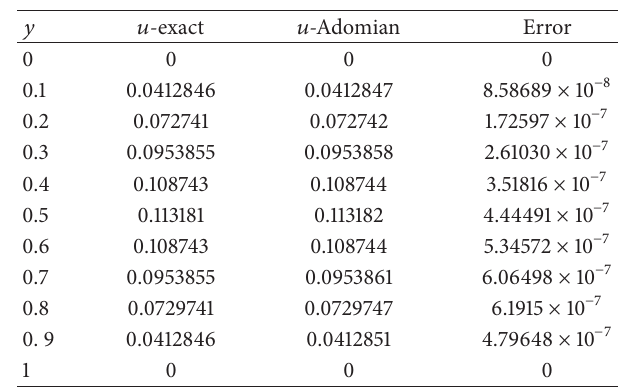
Table 1: Uniqueness results 𝑚 = 3 , 𝛽 = 1 .